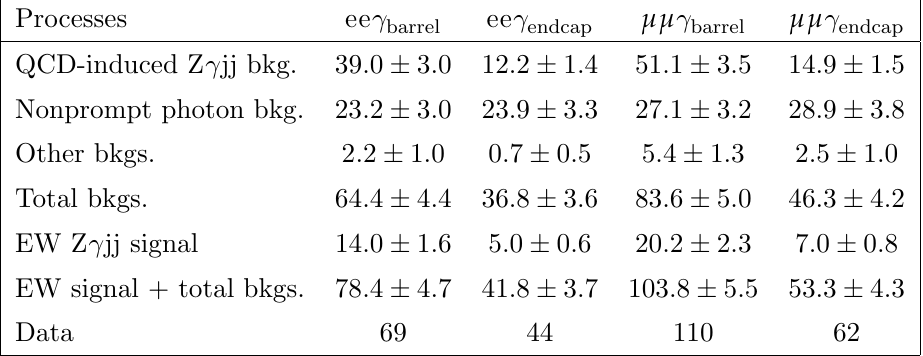
Table 3 . Post-(cid:12)t signal and background yields and observed event counts in data after the (cid:12)nal selection in the search for EW signal. The (cid:13) and (cid:13) represent photons in the barrel and barrel endcap endcap-detector region, respectively. \Other bkgs." represents the contribution of diboson, top and W (cid:13) process. The uncertainties are the quadratic sum of statistical and systematic